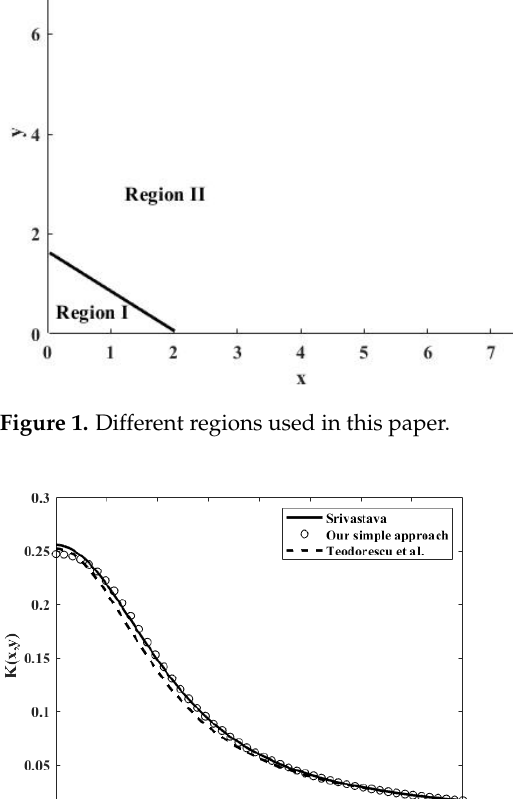
( ) , K x y in terms of x with 2. y =